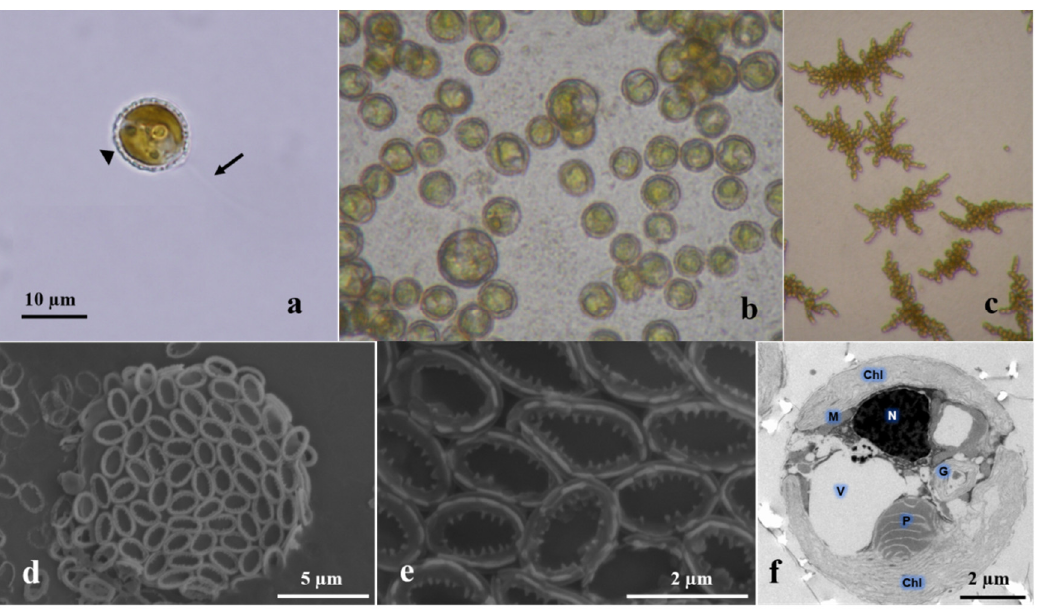
Figure 1. Microscopic images of Chrysotila roscoffensis (strain NMBjih026-8). ( a ) motile coccolith- bearing cell, showing two flagellates (arrow) and coccolith (arrow head). ( b ) nonmotile coccolith- bearing cells. ( c ) non-calcified filamentous colonies. ( d ) scanning electron microscope (SEM) image of coccolith-bearing cell. ( e ) SEM image of coccoliths. ( f ) transmission electron microscope (TEM) image of coccolith-bearing cell. Chl: chloroplast; G: Golgi apparatus; M: mitochondrion; N: nucleus; P: pyrenoid; and V: vacuole.